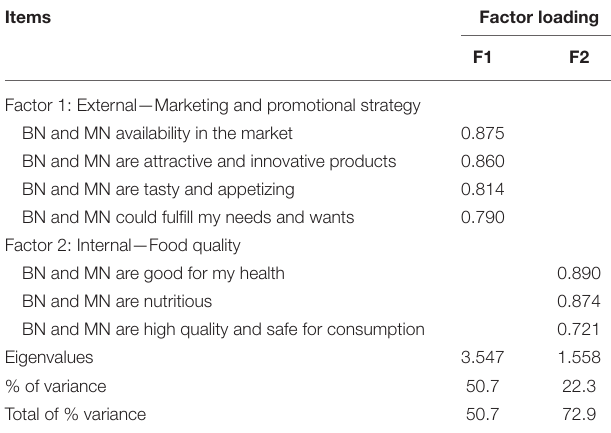
TABLE 4 | Factors motivating respondents to choose BN and MN as